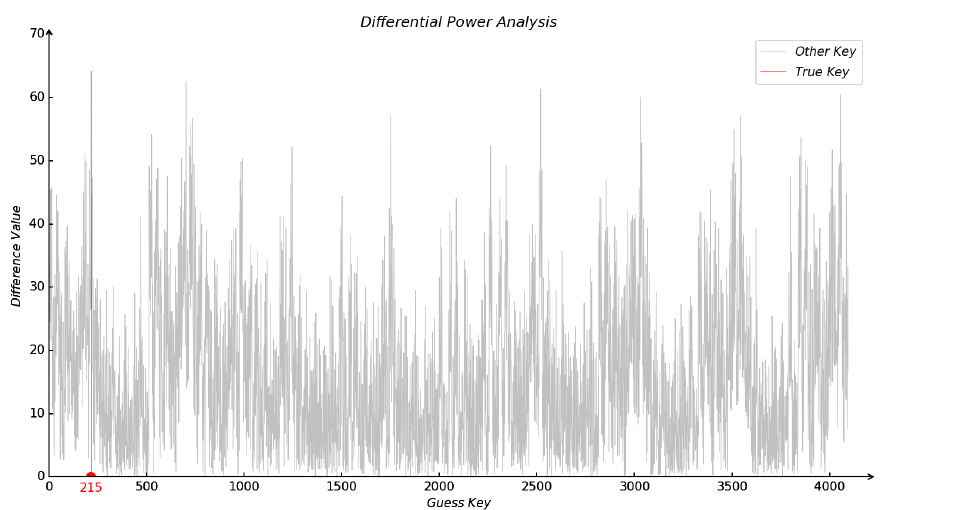
Figure 12. Group A: DPA result of experiment with all 12 rounds calculated by